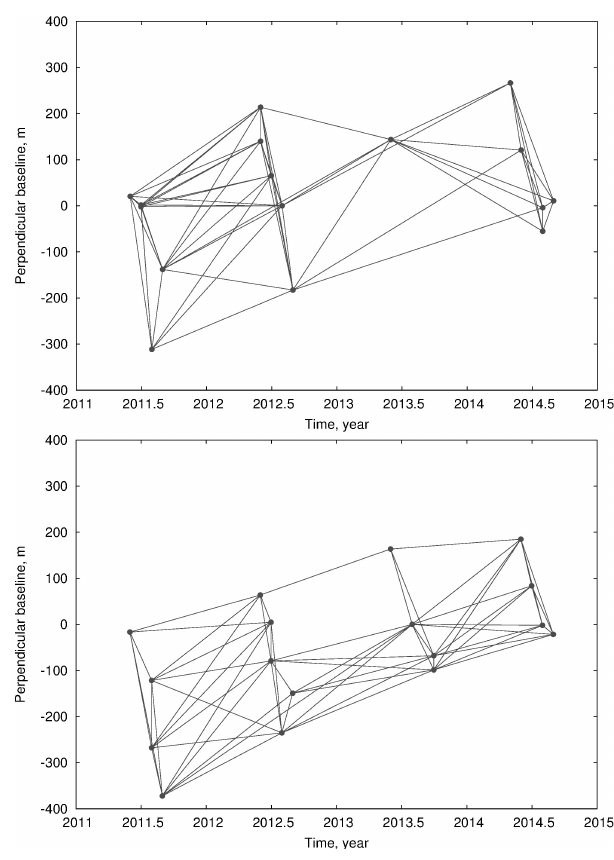
Figure 3. Perpendicular baseline and time span of ascending (top) and descending (bottom) interferograms used in this study. SAR acquisitions are marked as